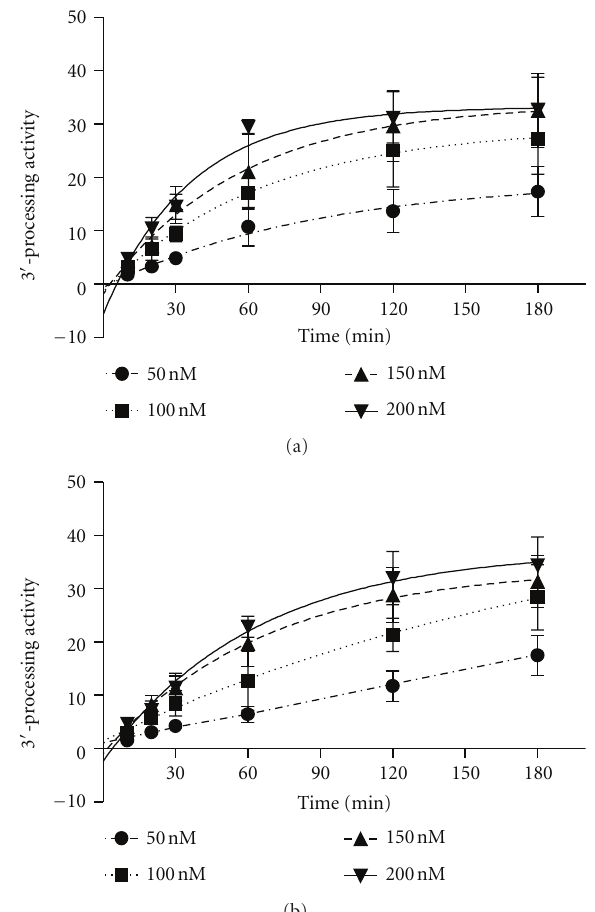
Figure 3: Kinetic comparison of HIV-1 B and CRF02 AG 33CR IN. (A) The kinetic features of recombinant HIV-1 B IN and (B) CRF02 AG IN (N 1 ) were determined in vitro using 3 (cid:2) -processing activity assay, in the presence of 50, 100, 150, and 200 nM recombinant IN proteins with an incubation time of 10, 20, 30, 60, 90, 120, and 180 min, respectively.